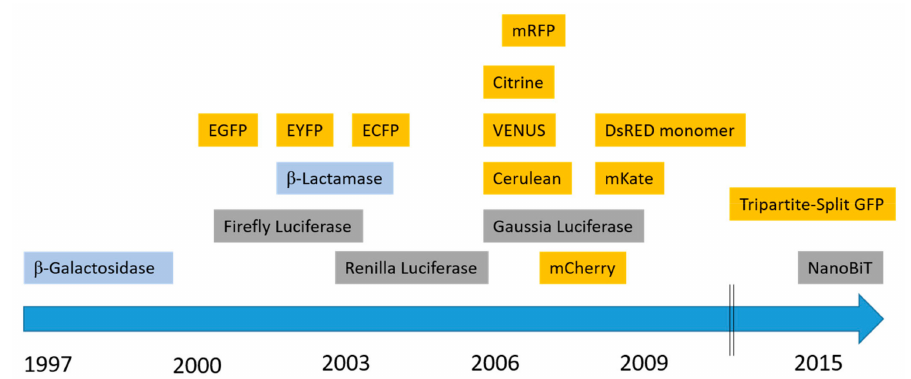
Figure 2. History of the development of split protein biosensors. Commonly used fluorescent split proteins (yellow), luminescent split reporters (grey), and enzymes with colorigenic substrates (blue) are